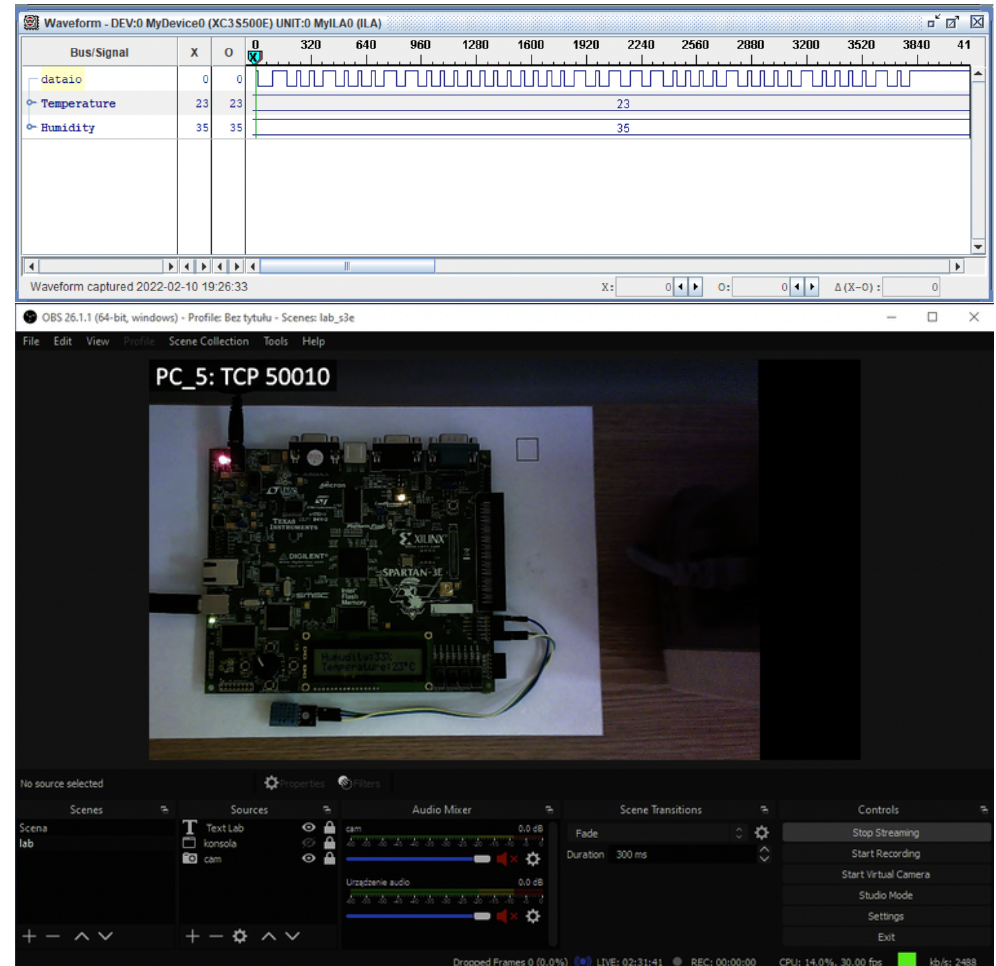
Figure 8. ( Top ) The chipscope temperature (in ◦ C) and humidity (in %) readings. ( Bottom )